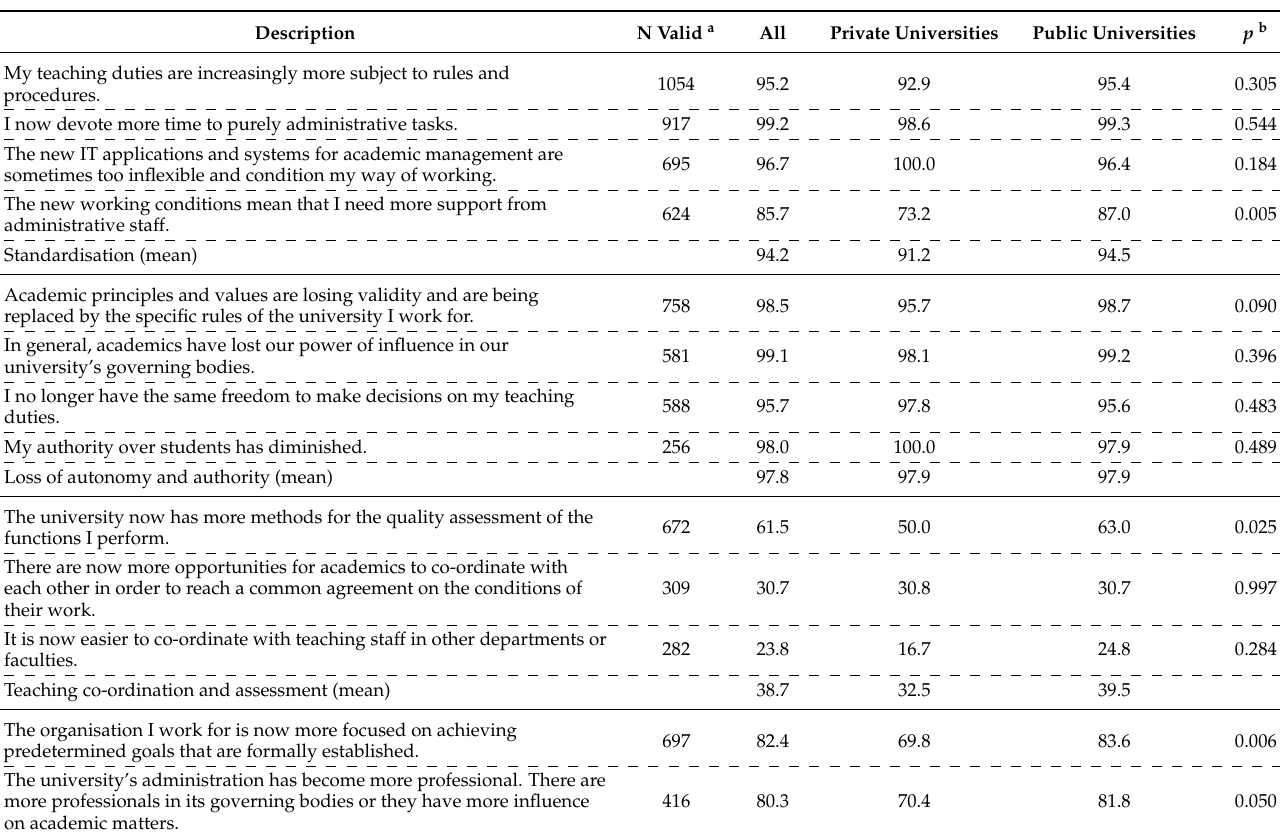
Table 4. Influence on job satisfaction of the organisational changes perceived (relative frequencies of individuals stating that the change described ‘has affected their job satisfaction for the worse’ or ‘for much worse’). Description N Valid a All Private Universities Public Universities p